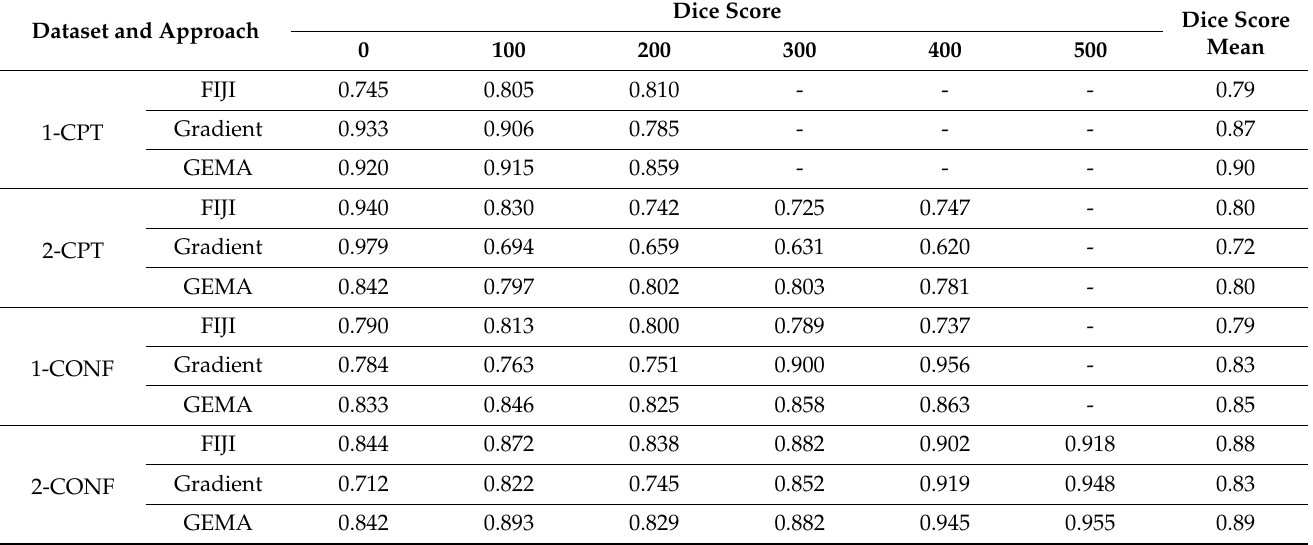
Table 2. Dice score computed through the confusion matrix by Gradient, FIJI and GEMA approaches relative to Gold-standard images.